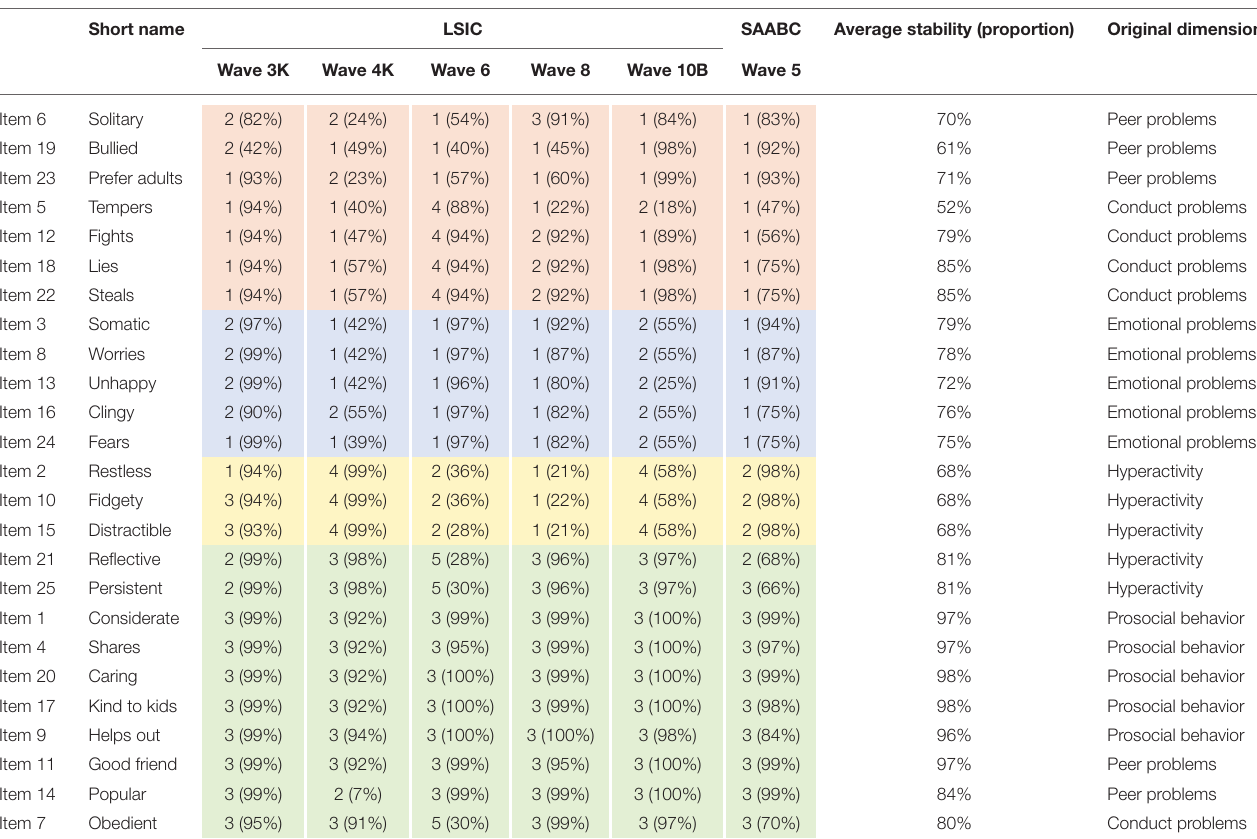
TABLE 3 | Item stability of SDQ